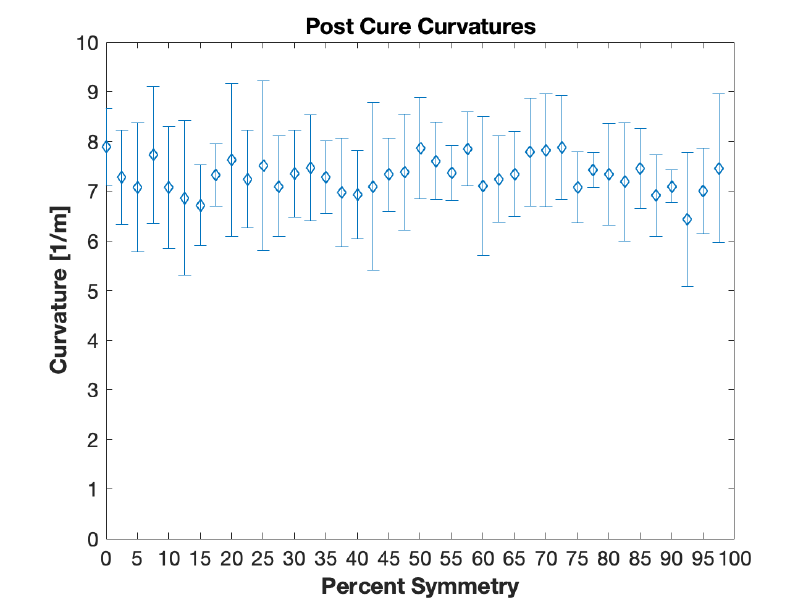
Figure 11. The post cure curvature versus the percent symmetry for all of the laminates studied. Error bars show ± one standard